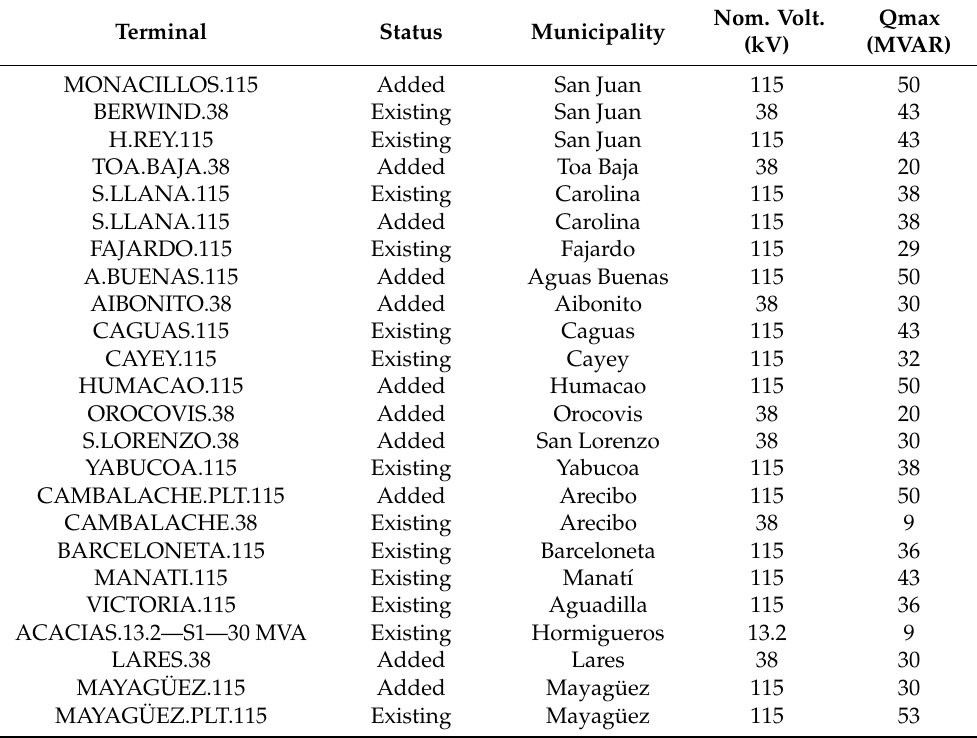
Table 12. List of existing and added capacitor banks in the simulated power